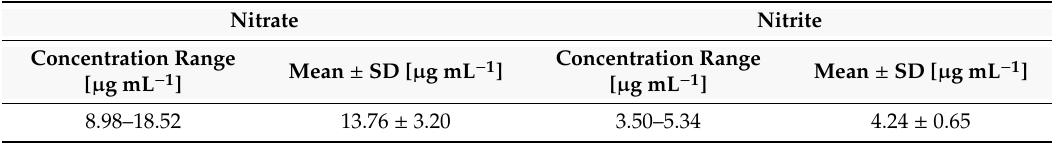
Table 4. Nitrate / nitrite levels in saliva samples ( n =